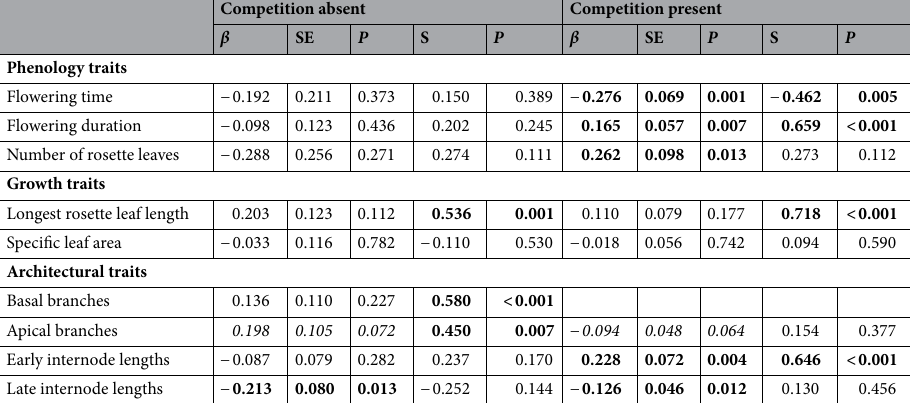
Table 1. Results of genotypic selection analysis showing selection gradients (β) with standard error values (SE) and selection differentials (S) for each competition treatment. Significant terms ( P < 0.05) are shown in bold and marginally significant terms (0.05 < P < 0.10) in italics.